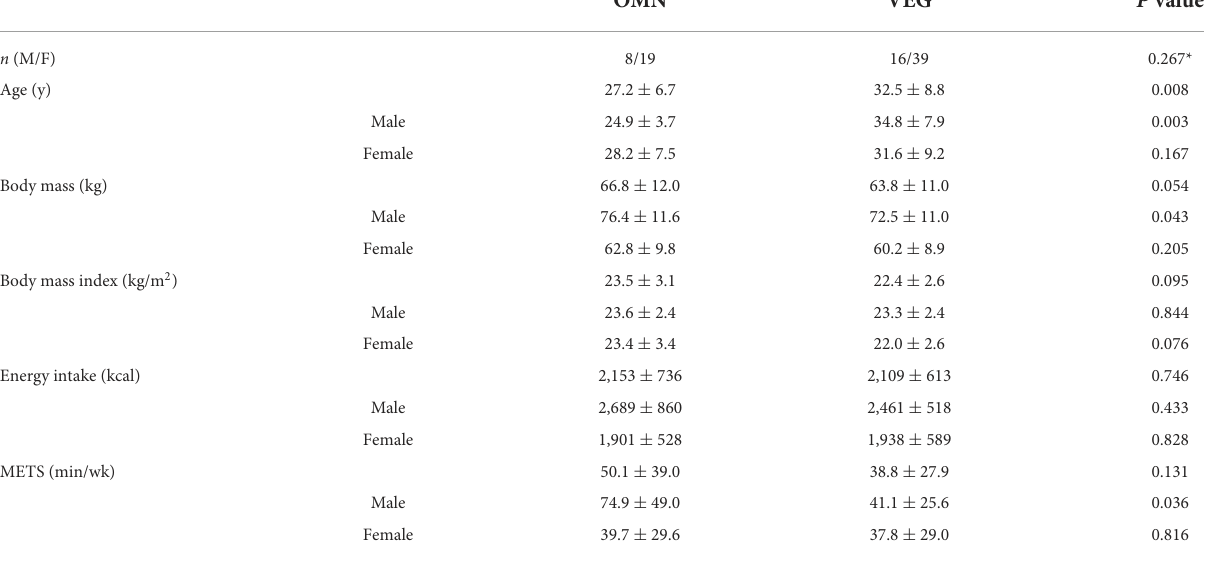
OMN VEG P value